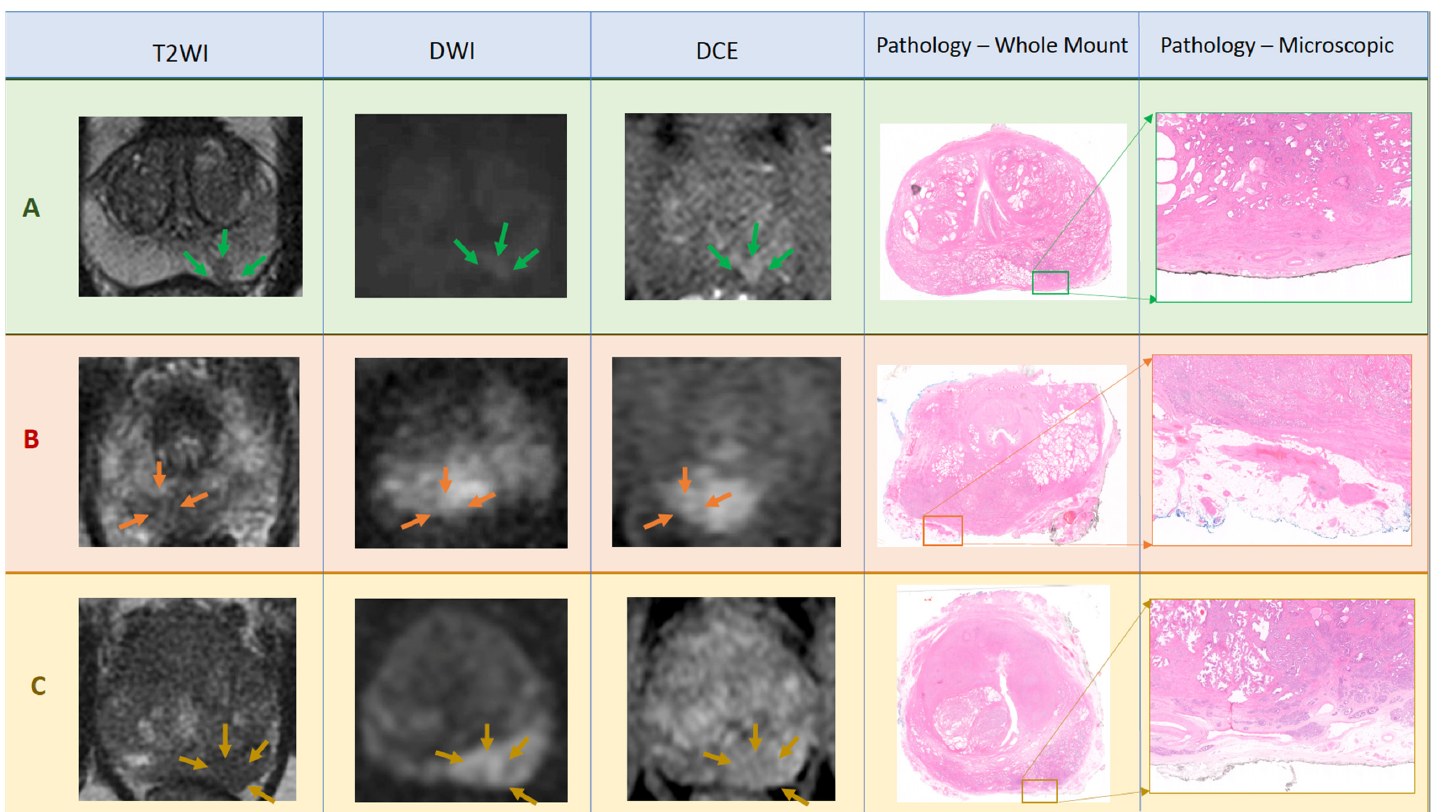
Figure 2. Panel of example mpMRI scan images with corresponding histological RP whole mount images including areas of interest for EPE displayed in further magnification. Patient A: Images from mid-gland show Likert score 2 Left-lesion in left peripheral zone posterior medial (green arrows). Corresponding pathology panels show pT2c including disease confined to the gland, and not extending to the inked margin, in the left posterior medial peripheral zone (×1.5). Patient B: Images from apex of gland show Likert score 4 Right-lesion in right peripheral zone posterior medial showing irregularity and bulge (orange arrows). Corresponding pathology panels show pT3a including disease extending into the fat for 2 mm but clear of the inked margin (×1.42). Patient C: Images from base of gland show Likert score 5 Left-lesion in left peripheral zone posterior medial and posterior lateral demonstrating abutment, irregularity, bulge, and ‘measurable EPE’ (gold arrows). Corresponding pathology panels show pT3a including disease extending circumferentially beyond capsule and into the fat for 8 mm but clear of the inked margin (×1.5). All DWI images have b value of either b1400 or b2000.